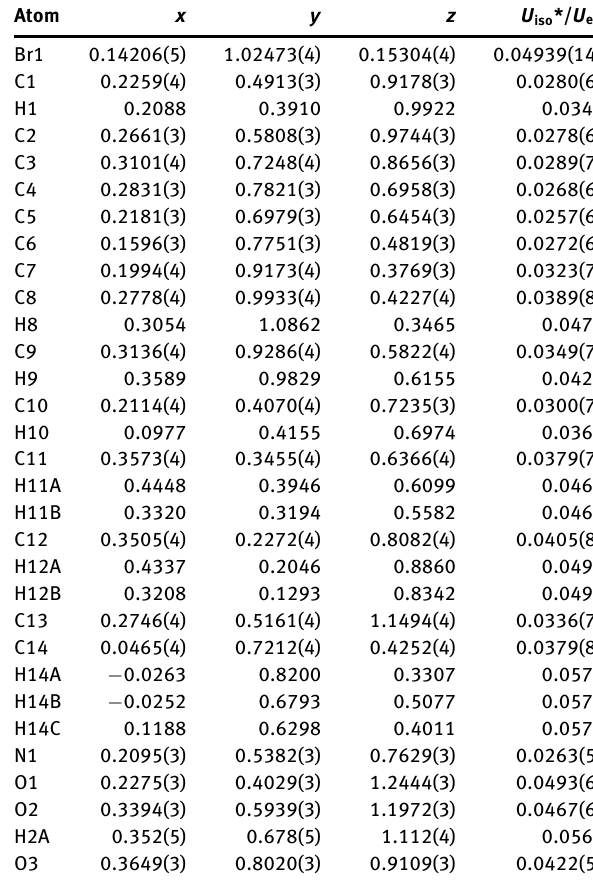
Table 2: Fractional atomic coordinates and isotropic or equivalent isotropic displacement parameters (Å 2